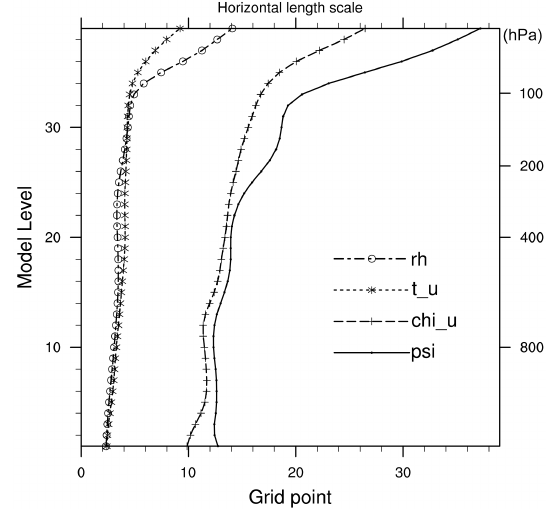
Figure 9. Horizontal length scales for CV5. t u and RH, which have more local structures, are modeled by shorter length scales (WRF, res. 15km, D-ensemble, RFs).